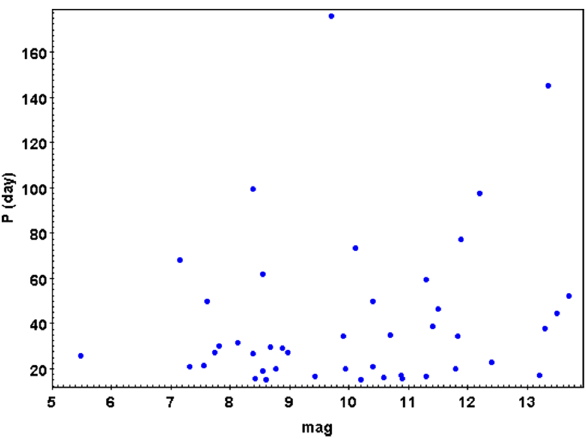
Figure 1: Distribution of our sample by the period and